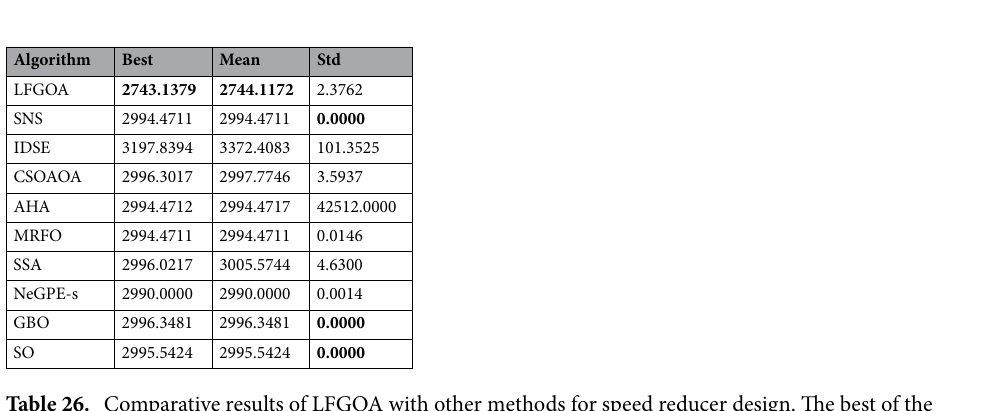
Table 26. Comparative results of LFGOA with other methods for speed reducer design. The best of the comparison results are in [bold].